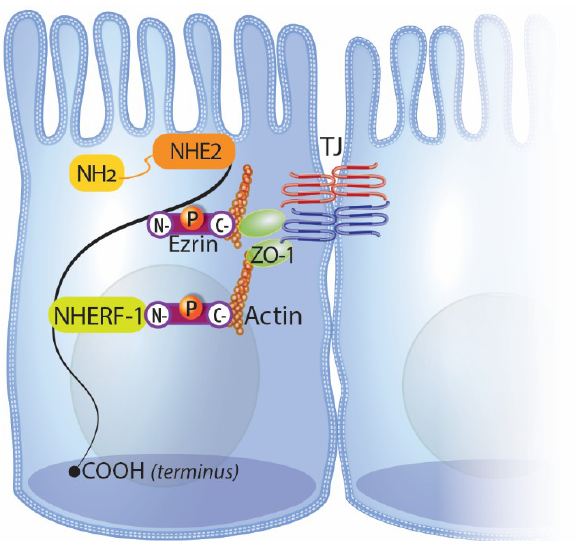
Figure 1. Schematic representation of the potential link of NHE2 to the actin cytoskeleton and subsequently the tight junction through binding partners. The primary candidate protein linking NHE2 to the actin cytoskeleton is phosphorylated ezrin. Based on information known about NHE3 and data from NHE2 in vivo studies, NHE2 may bind directly to ezrin or indirectly through additional binding partners, including NHERF1/EBP50.